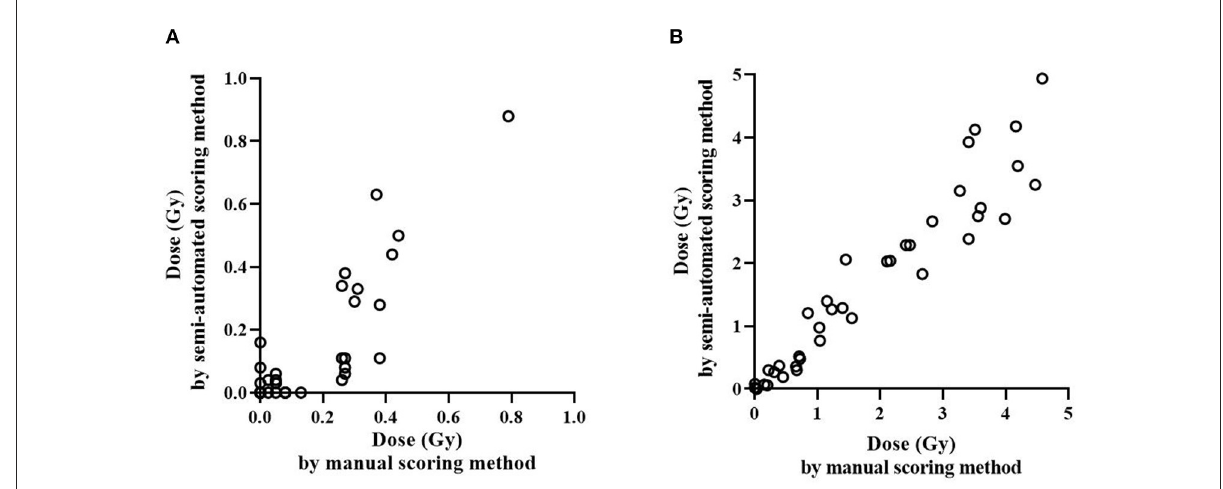
FIGURE3 Comparison of radiation dose estimation by the manual and semi-automated scoring methods. Irradiated dose of ex vivo and in vivo samples were estimated and compared using the manual and semi-automated scoring method. Dose estimation of in vivo occupationally exposed samples (A) and ex vivo irradiated samples (B) is